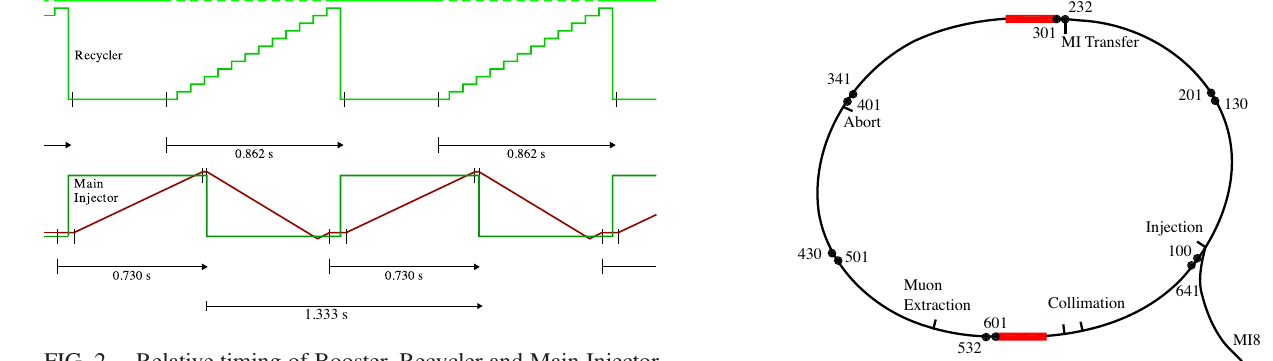
FIG. 2. Relative timing of Booster, Recycler and Main Injector cycles for NOvA-era operations. The beam present in each machine is shown along with the Main Injector momentum ramp in red.